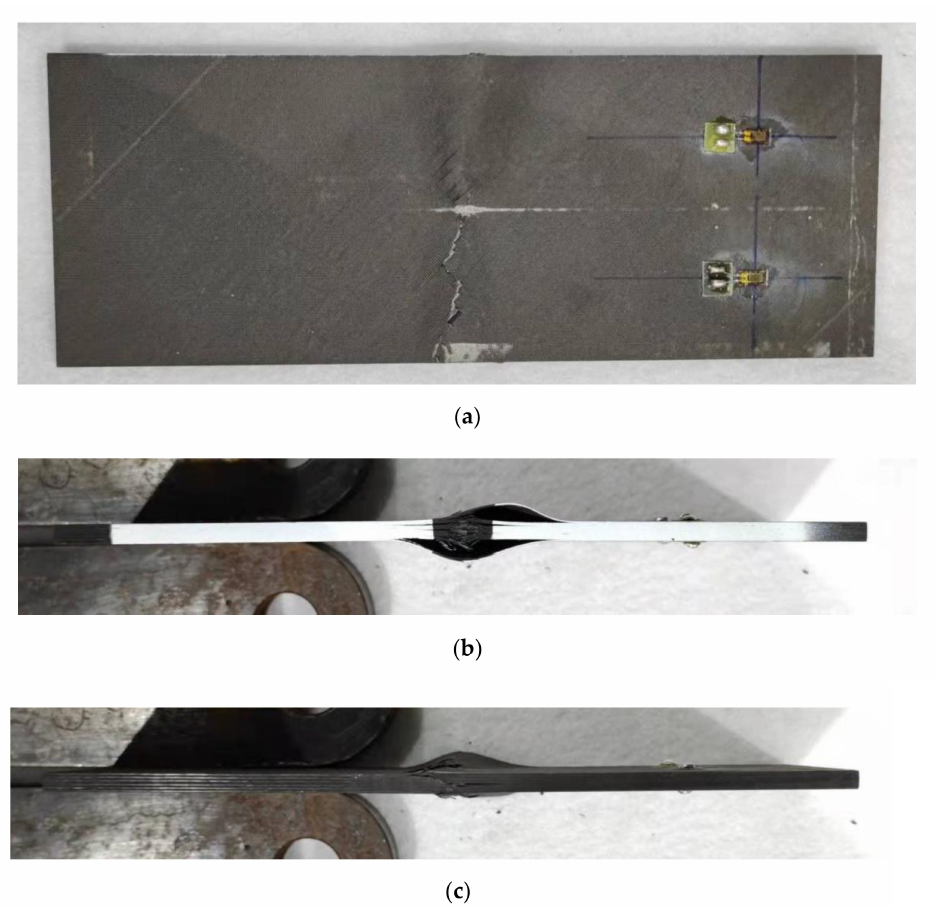
Figure 11. CAEI failure picture of the specimen at 10 J. ( a ) Front view; ( b ) impact edge side view; ( c ) non-impact edge side view.